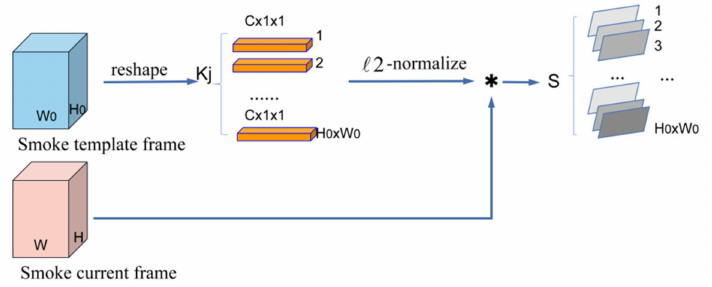
Figure 3. Correlation between the template frame and the current